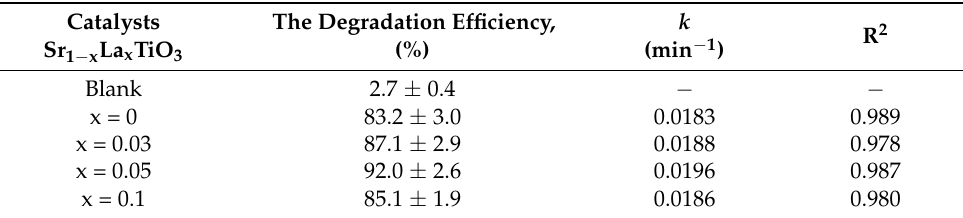
Table 4. The degradation efficiency and pseudo-first-order rate constant of Sr 1 − x La x TiO 3. Catalysts